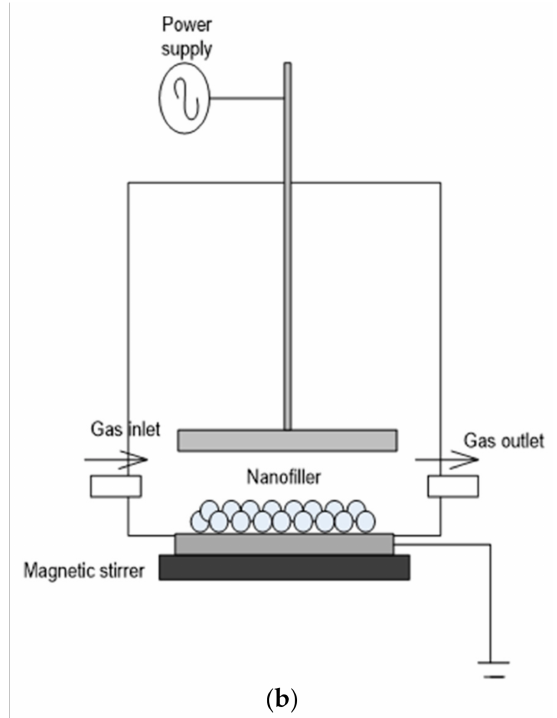
Figure 1. Plasma experimental setup: ( a ) Schematic diagram of plasma treatment setup, ( b ) setup of the DBD plasma chamber.